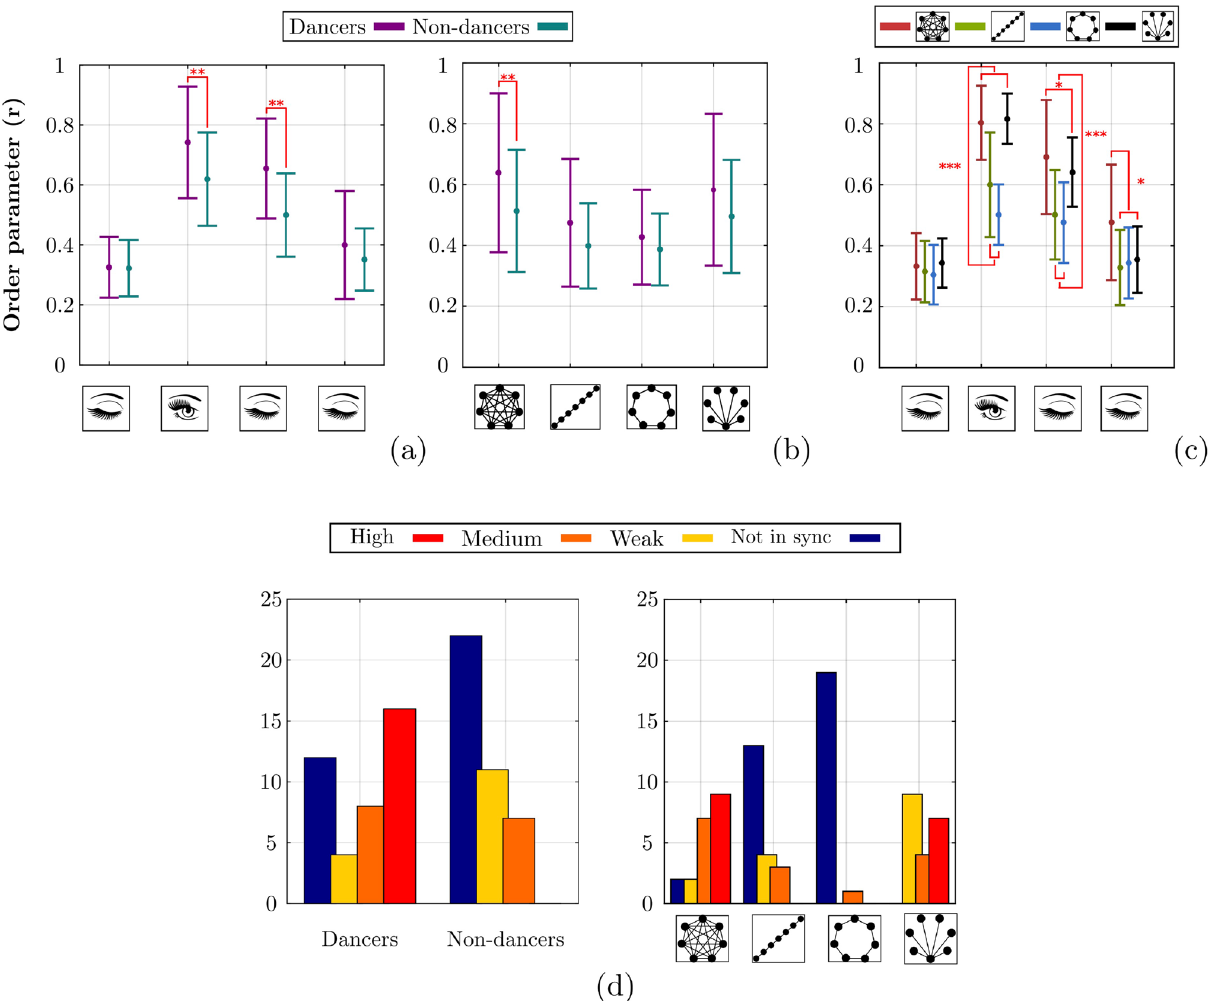
Figure 3. Main results of Experiment 2. Mean and standard deviation of Phase synchronization r in Experiment 2 as a function of ( a ) Vision × Expertise, ( b ) Expertise × Topology, ( c ) Vision × Topology, n = 320 ; ( d ) distribution of phase synchronization levels across categories of robustness for Expertise (left panel) and for Topologies (right panel), n = 80